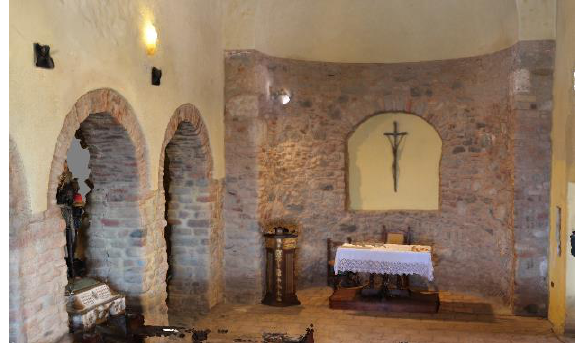
Figure 4. 3D Model -